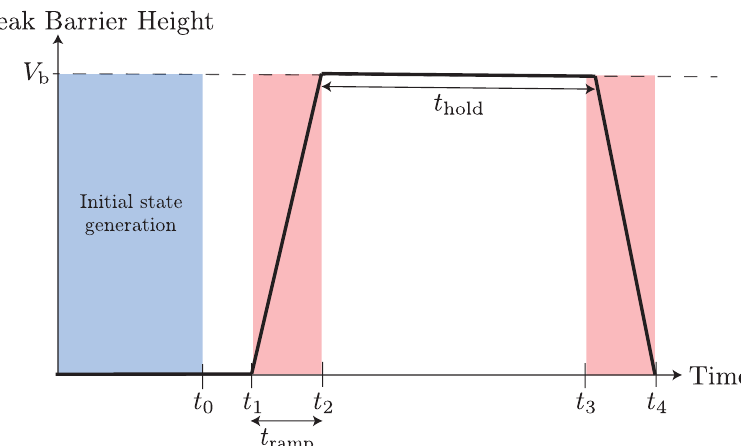
Figure 3: Schematic of the simulation protocol, characterised by peak barrier height [ U ( r , θ , t )] = χ ( t ) V max as a function of simulation time. In each simulation, r , θ b b the initial state is first generated (shaded blue) by evolving the SPGPE to equilibrium for t < t . At t = t , the initial state sample is seeded with quantum fluctuations and 0 0 − t imprinted with a 2 π phase winding. After some time t , the barrier is linearly 1 0 ramped up over a period of time t until it reaches its maximum height ( χ = 1) ramp at t = t . The barrier is held at that maximum height for time t and then linearly 2 hold < t < t ramped down over the period t 3 4